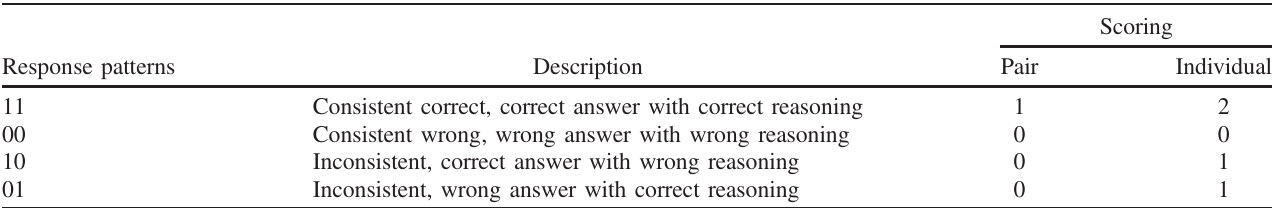
TABLE II. Question-pair score response patterns. A correct answer is assigned with 1 and a wrong answer is assigned with